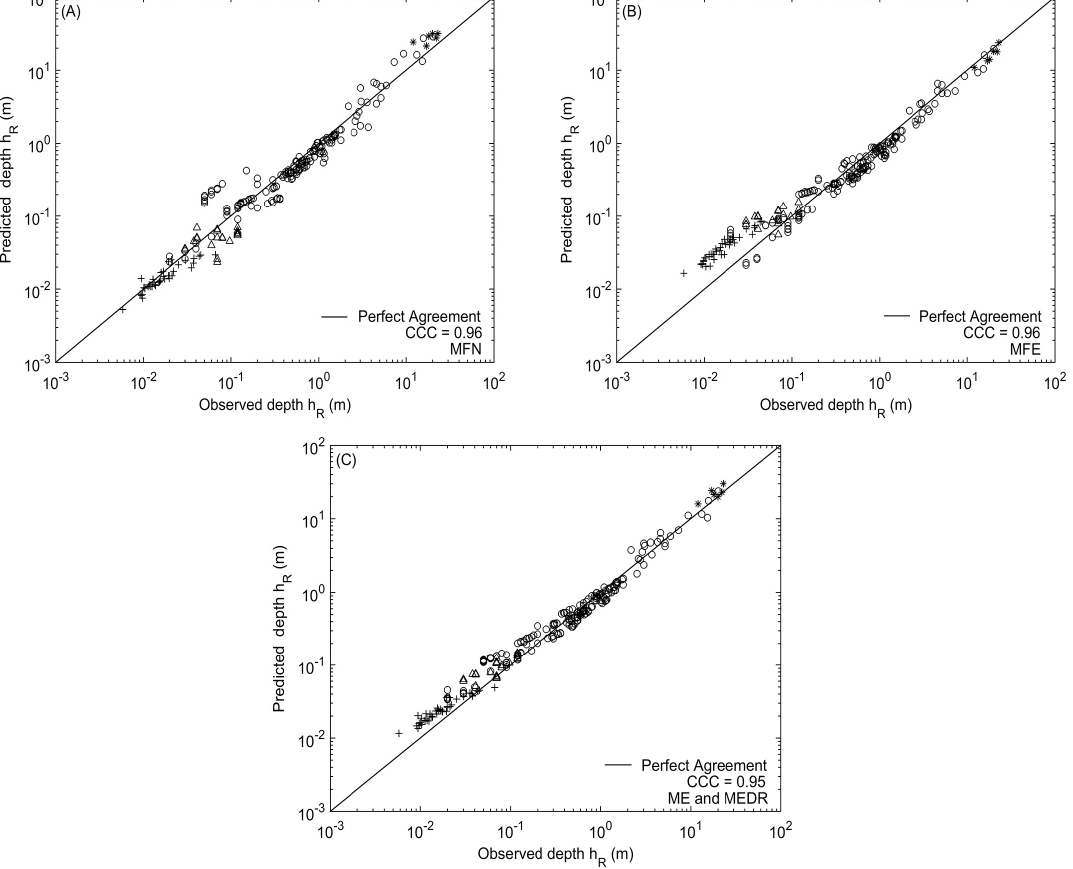
Figure 2. Comparison of predicted and observed depth h R for sand bed channels [27,45–47]. ( A ) MFN; ( B ) MFE; ( C ) ME and MEDR. Same legend as on Figure 1 applies here.